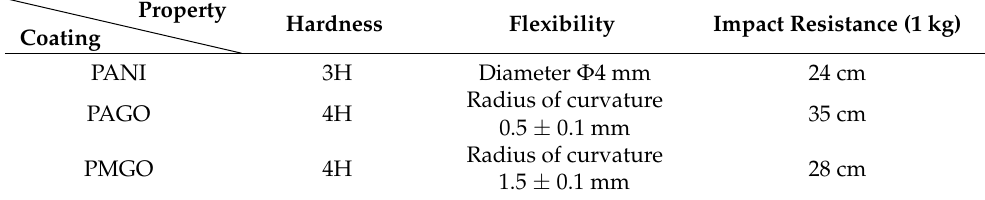
Table 2. Test results of the physical properties of the coating .